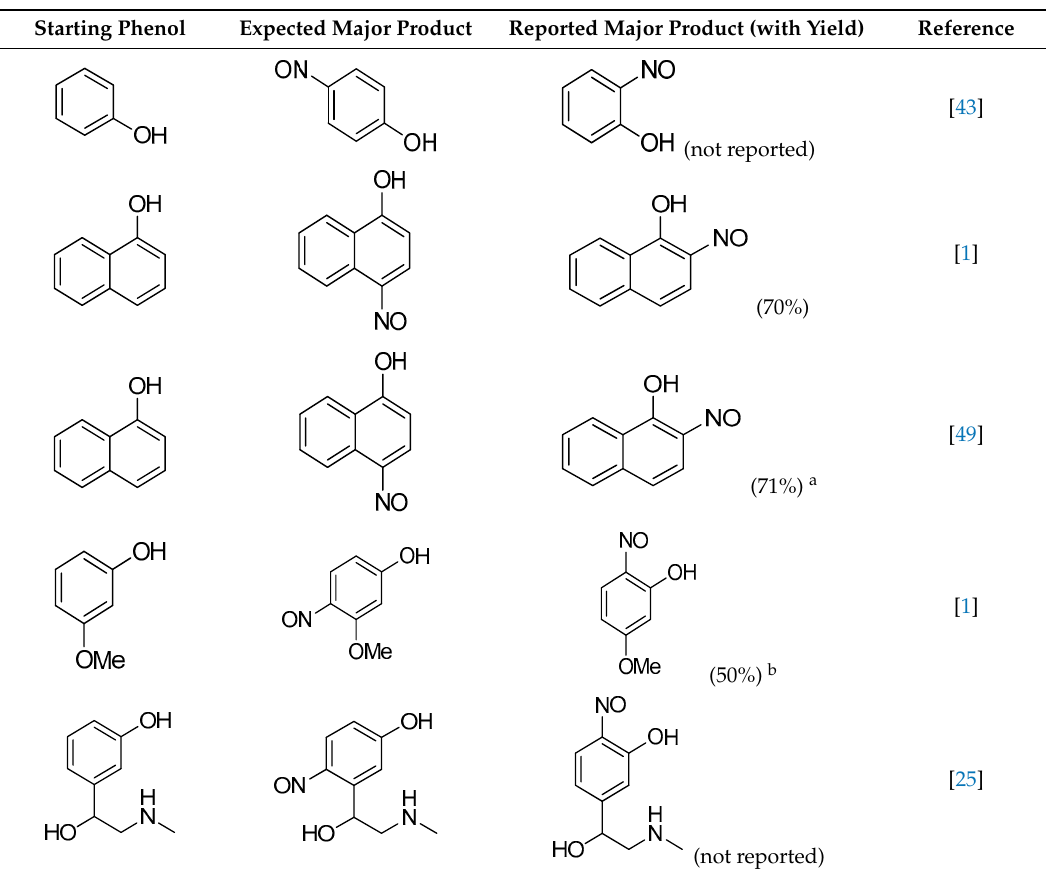
Table 3. A selection of literature results that show the organic ligand of the major product from copper-mediated nitrosation is the same as might be expected for the nitrosation in the absence of copper.